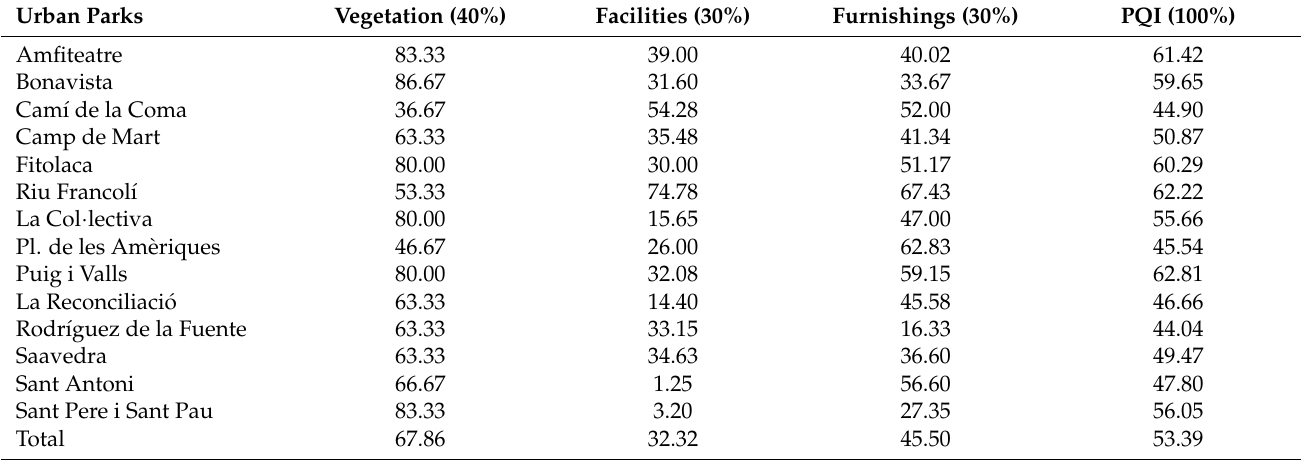
Table 3. PQI values for each park and each